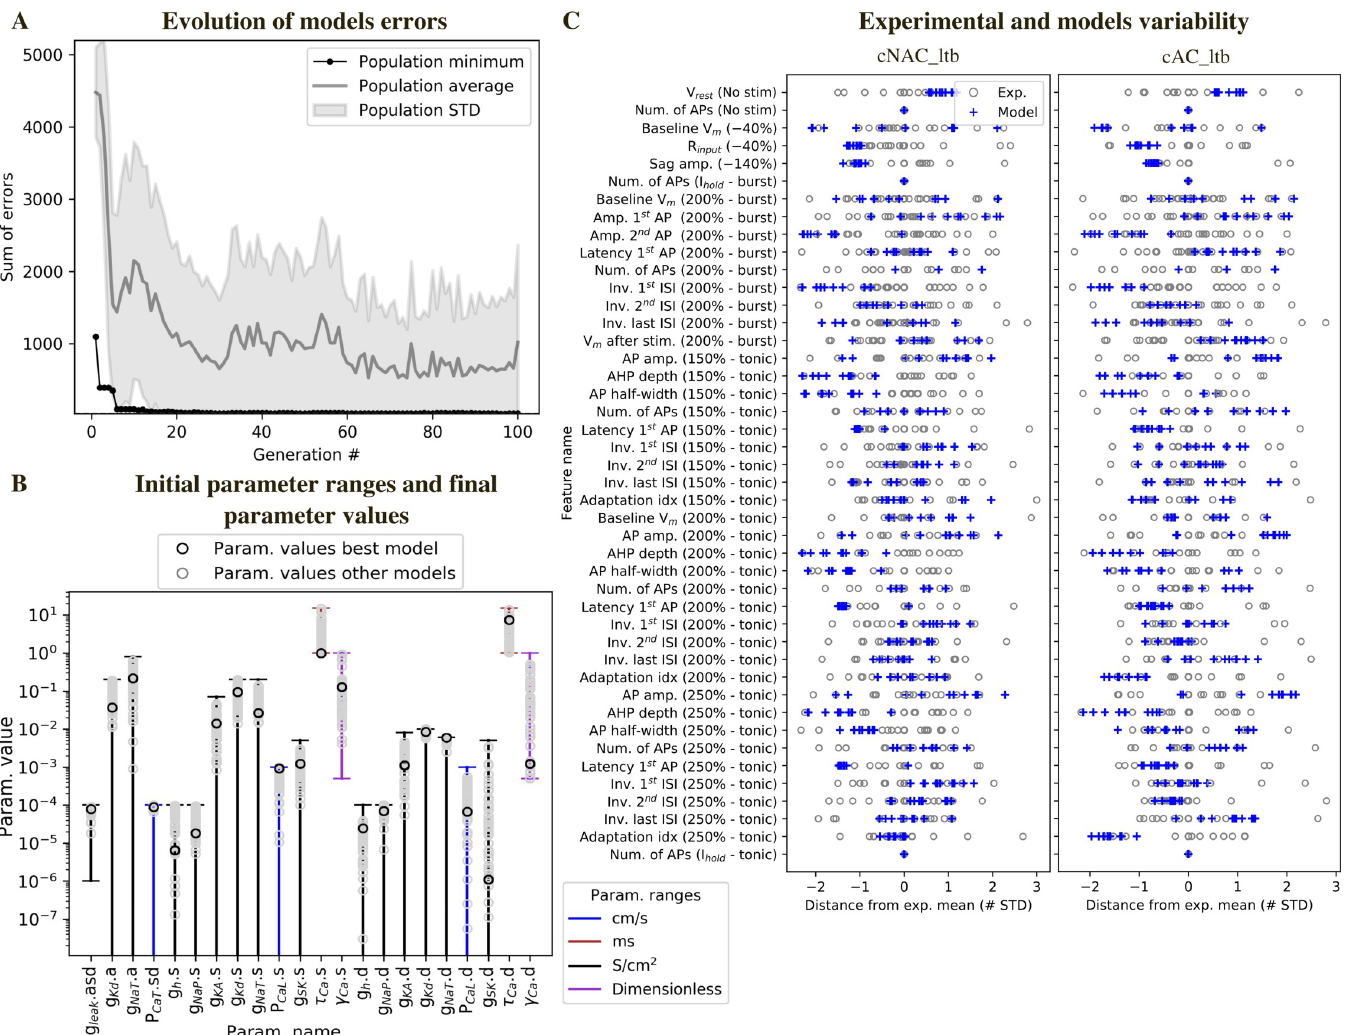
Fig 5. Diversity of model parameters and experimental variability. (A) Example of model fitting errors (sum of all feature errors) during optimization. (B) Initial parameter ranges and diversity of solutions. Each vertical line represents the range for the parameters, when the horizontal lower bar is missing the bound is 0. The characters following”.” in the parameter name specifies the morphological compartment for the parameter (”s”: soma,”d”: dendrites,”a”: axon). Black circles: parameter values for one of the models in Fig 4, grey circles: parameter values of the models with all feature errors below 3 STD. (C) Features variability in the models and experiments. Blue crosses: feature errors of a sample of 10 models. Each grey circle is the z-scored feature value of one experimental cell, obtained from the feature values shown in Fig 3. The protocol names are shown in parenthesis and corresponds to the stimuli shown in Figs 1 and 4, tonic and burst refer to the holding current as in Fig 1.